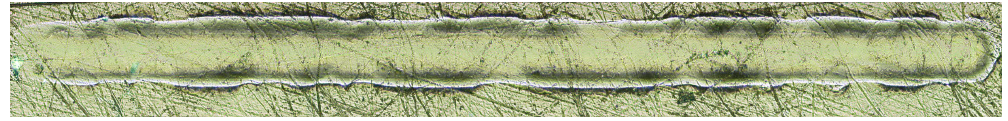
Figure 8. Test scratch on the surface of the 4A material.